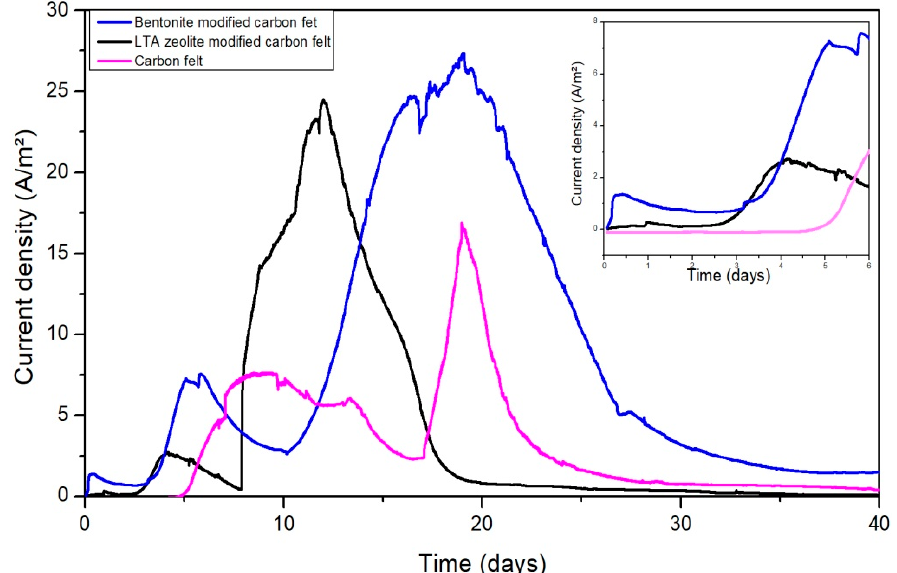
Figure 3. Evolution of the current density on raw carbon felt and modified carbon felt electrodes polarized at − 0.2 V vs. SCE in tannery wastewater and 20 mM of acetate inoculated with acclimated activated sludge. The inset gives a closer look at the first six days of the experiments. Cyclic